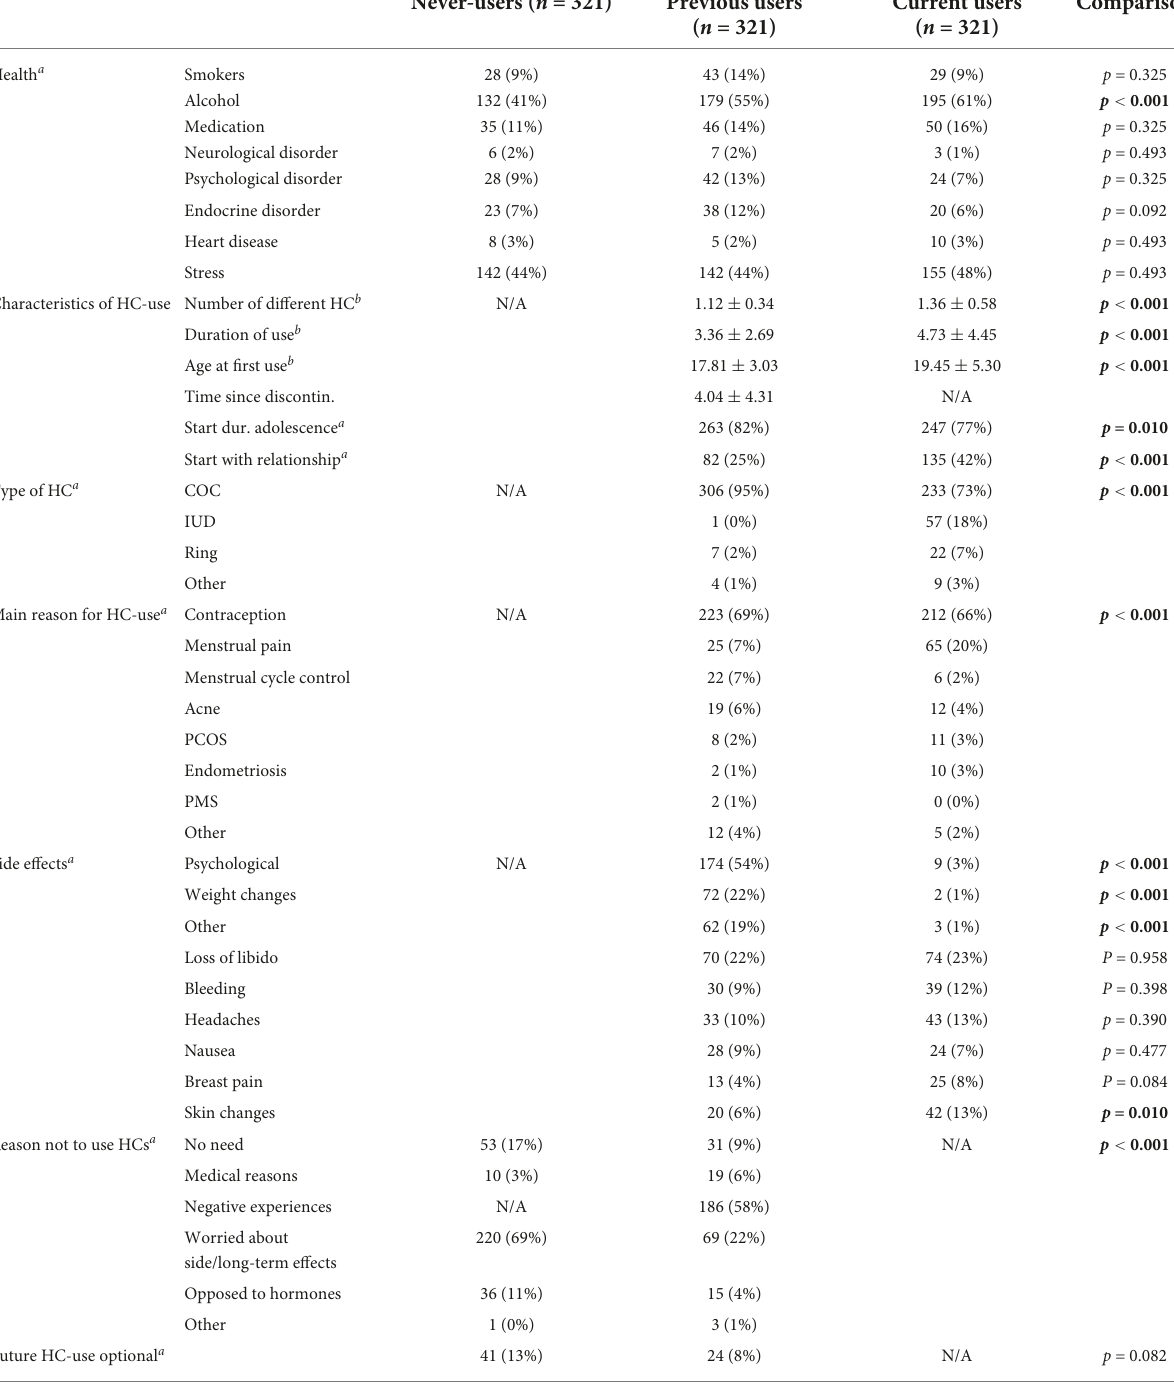
TABLE 3 Comparison of health variables and HC-characteristics between current and previous HC-users and never users matched for age, language, sexual orientation, and relationship status.